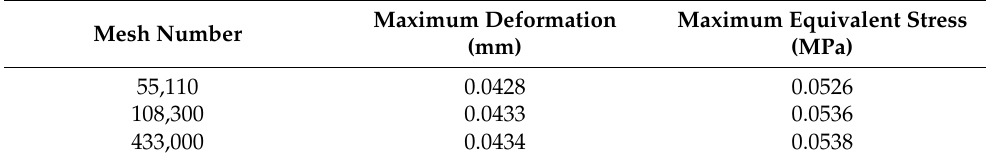
Table 2. Mesh independence verification.